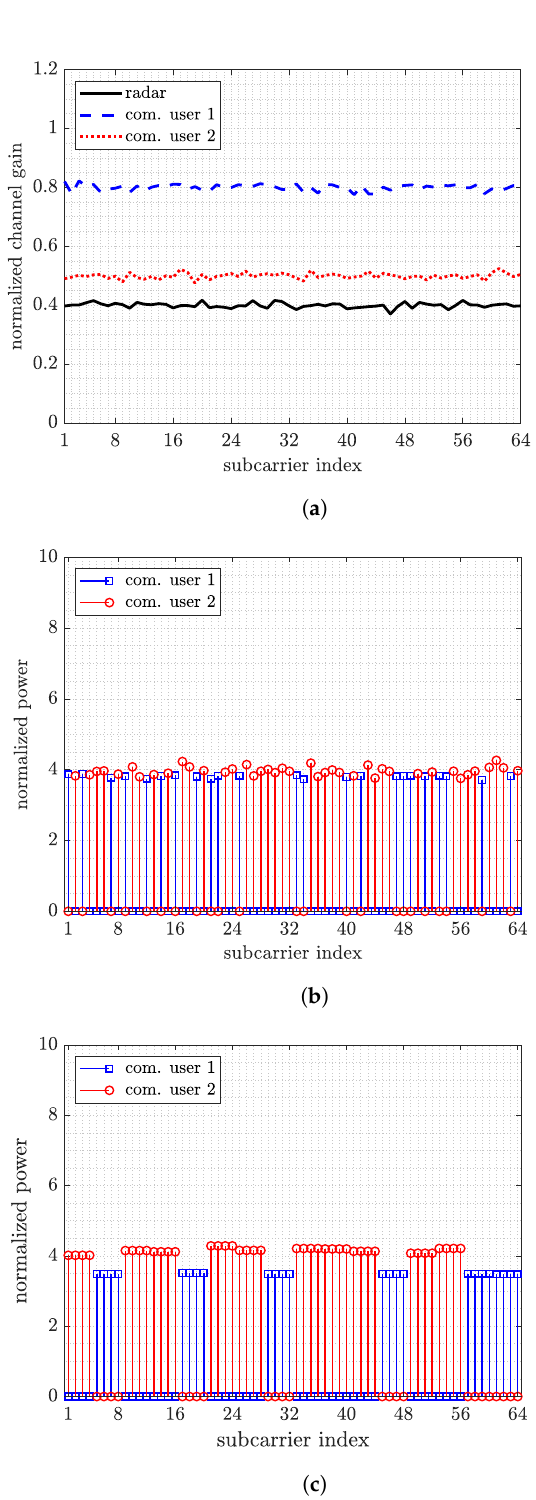
Figure 10. Worst-case cooperative design for power allocation and subcarrier assignment in the case of relatively flat radar and communication channels. ( a ) Simulation scenario. ( b ) Worst-case MI maxi- mization ( I ( y rad ; h | s ) = 22.35, I ( y com,1 ; g 1 | s ) = 20.58, I ( y com,1 ; g 2 | s ) = 20.58). ( c ) Worst-case com- munication MI maximization ( I ( y rad ; h | s ) = 22.48, I ( y com,1 ; g 1 | s ) = 20.42, I ( y com,1 ; g 2 | s ) =